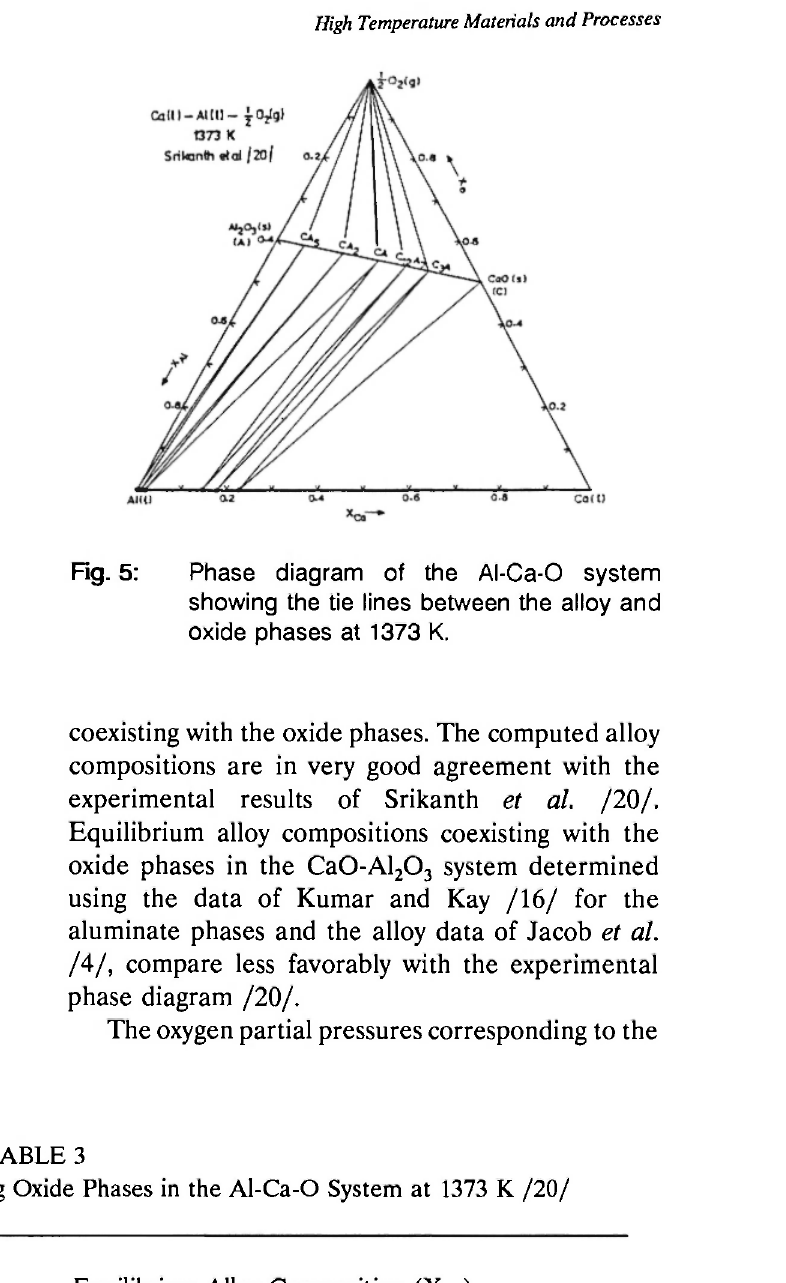
Equilibrium Alloy Composition (XQ,)